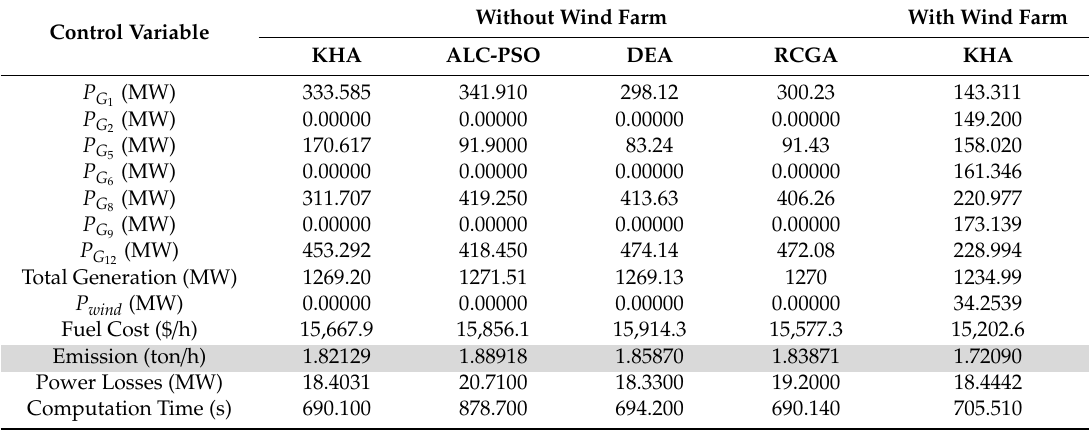
Table 10. Results for minimizing the active power losses across the transmission lines for the Test System